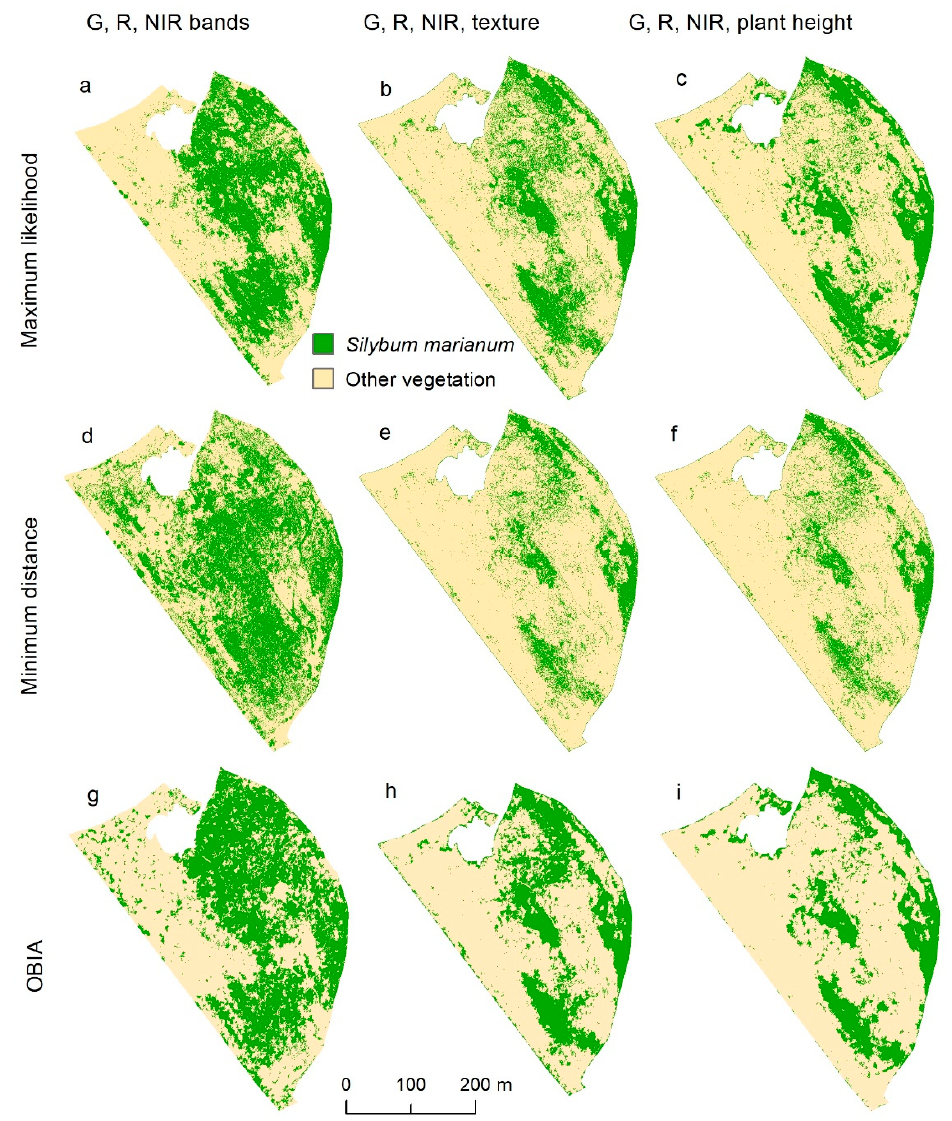
Figure 5. Weed distribution maps using three classifiers on various input layers acquired on 19 May 2015. G, R and NIR are the green, red and near-infrared bands of the UAV orthomosaic, respectively, OBIA is object-based image analysis.